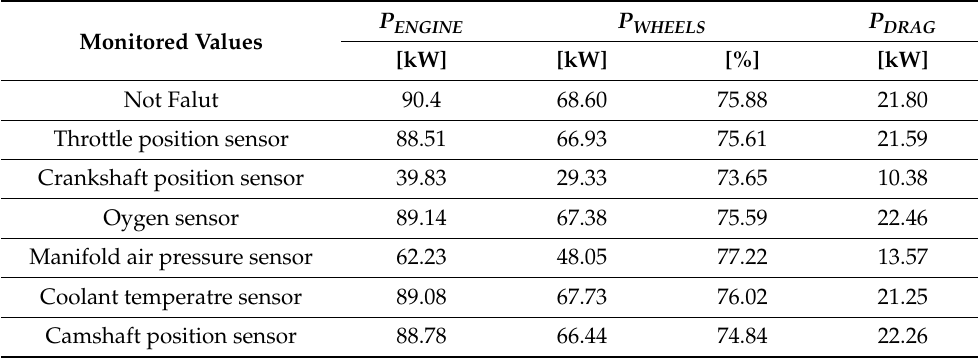
Table 4. Average values recorded during power measurement